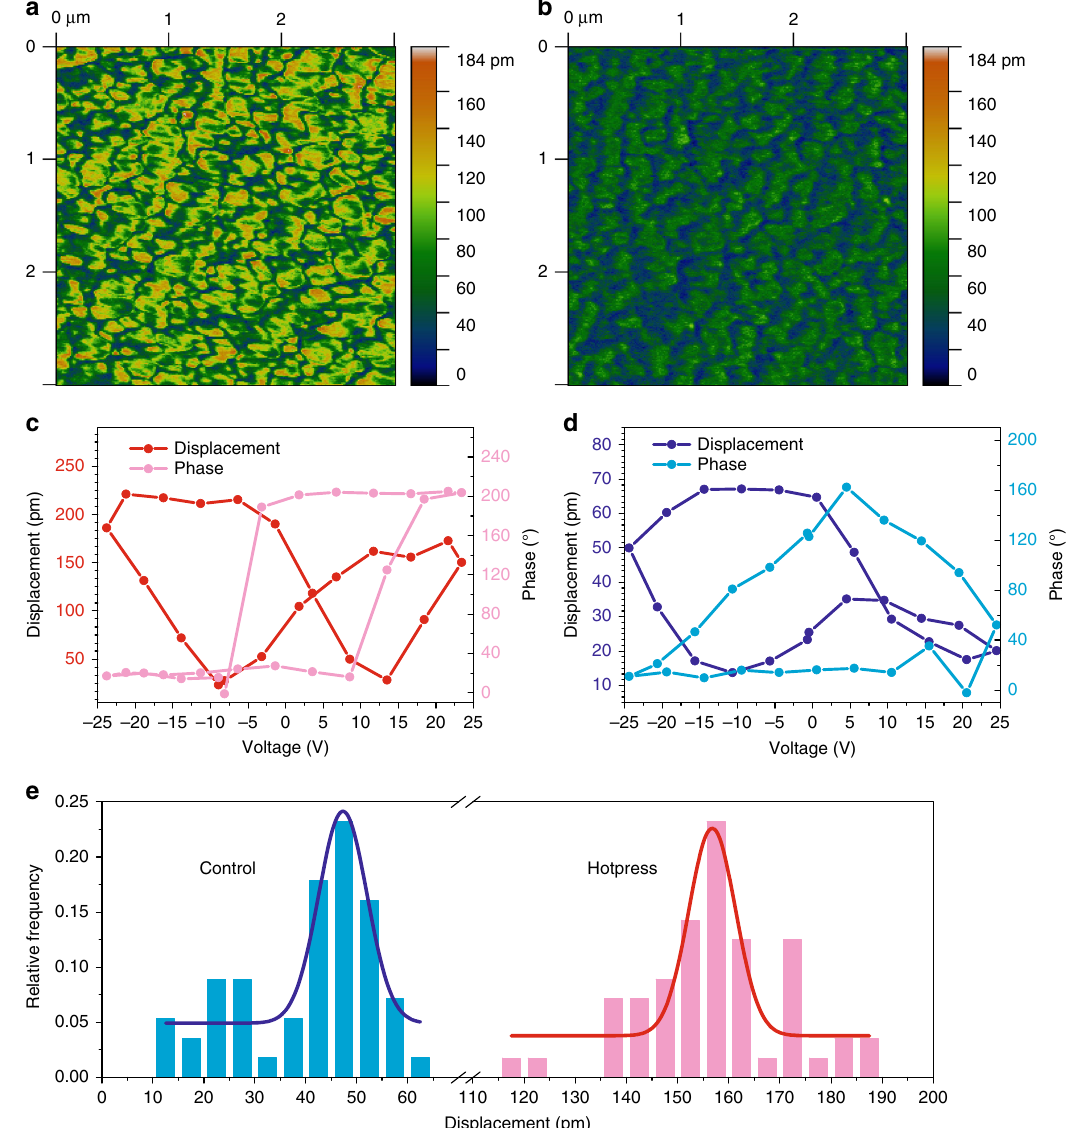
Fig. 5 Effect of treatment on piezoelectric response measured by PFM. a , b PFM amplitude images of a hot-press and b air-dried samples. A conductive tip is used to apply a constant bias of 9.4 V to induce local ME displacement while imaging. c , d Piezoelectric butter fl y loops of c hot-press and d control cellulose fi lms elucidated by using SS-PFM. The red and blue dots are the hysteresis loops representing the bias-induce amplitude displacement. The pink and cyan dots represent phase changes corresponding to the hysteresis loops. e Histograms of bias induced amplitude displacement at applied voltage of − 25 V during SS-PFM